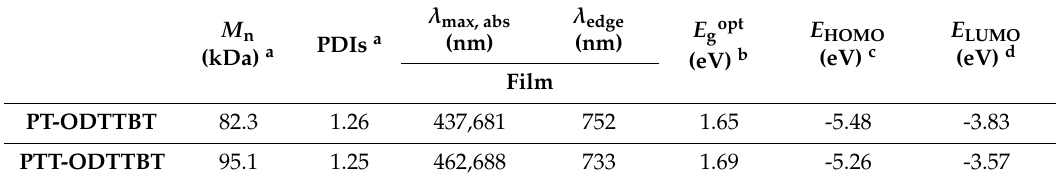
Table 1. Molecular weight, optical, and electrochemical properties of the synthesized